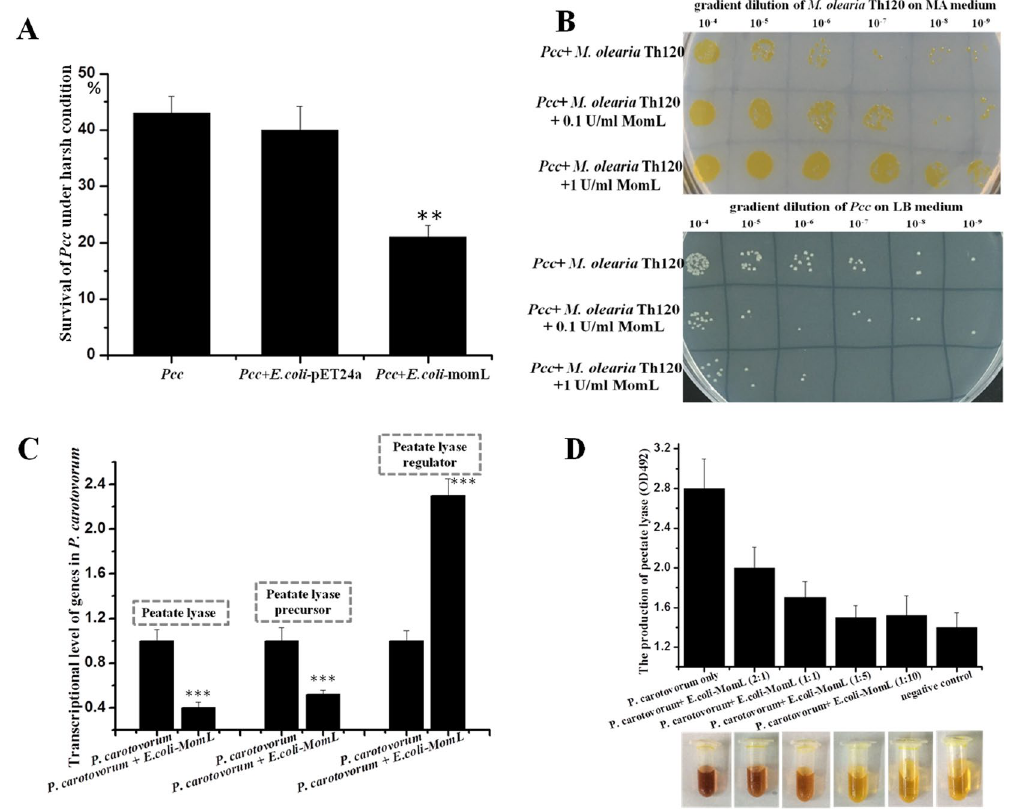
Figure 4. Co-cultivation assays of different bacterial species. ( A ) P. carotovorum subsp. carotovorum ( Pcc ) and E. coli-momL co-cultivation. E. coli and E. coli - pET24a are used for the negative control. ( B ) Pcc and Muricauda olearia Th120 co-culture on 10% TSB medium containing 2 mM H 2 O 2 . After culturing, the cultures were serially diluted and spread onto MA and LB plates, separately (MA and LB were medium for M. olearia Th120 and Pcc respectively. What is more, marine bacterium M. olearia Th120 can not survive on LB medium, while, Pcc can not live on MA medium). ( C ) Transcriptional analysis of pectate lyase genes of M. olearia Th120. ( D ) Detection of pectate lyase